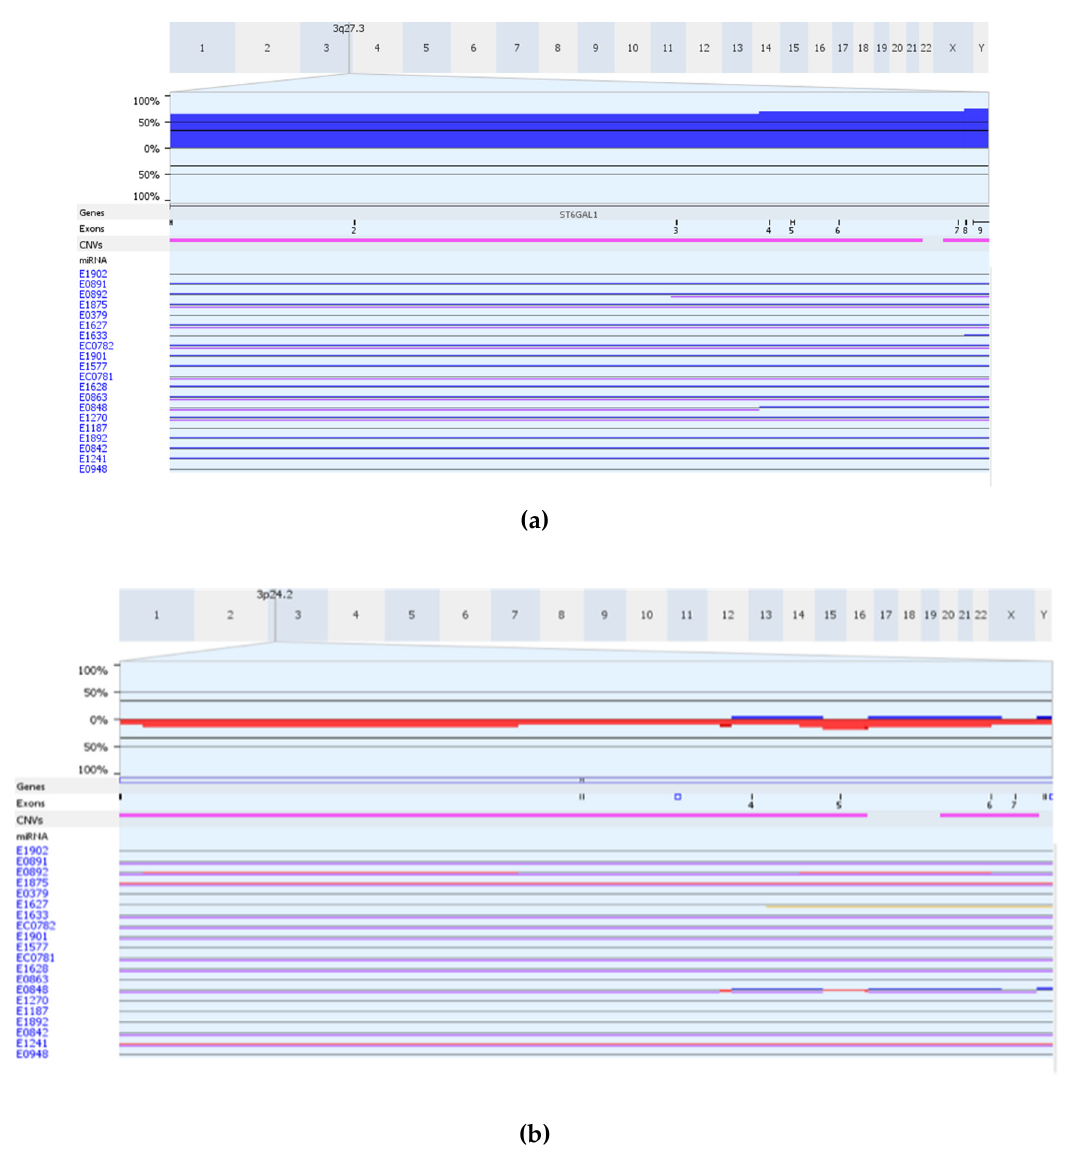
Figure 4. Somatic alteration on ST6GAL1 and RARB in 76 ESCC were analyzed. The copy number change images for two genes, ( a ) ST6GAL1 and ( b ) RARB were shown for 20 ESCC samples as assay examples. On each image, the top portion showed the distribution of somatic alteration and the bottom portion showed individual samples in multiple rows. The colors blue, red, and purple indicated copy number gain, copy number loss, and allelic imbalance, respectively.